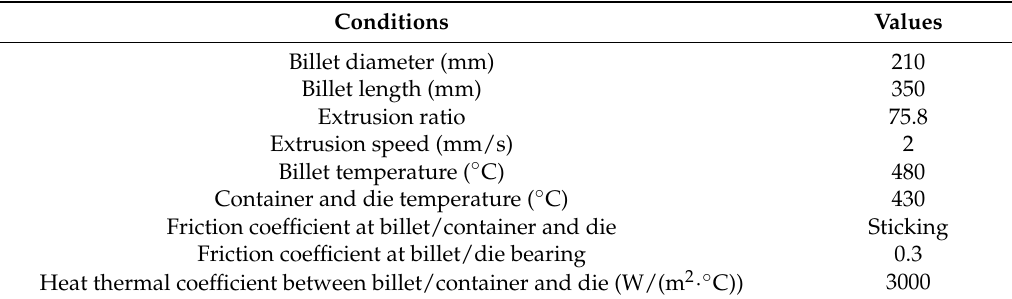
Table 2. Process parameters used in simulation.